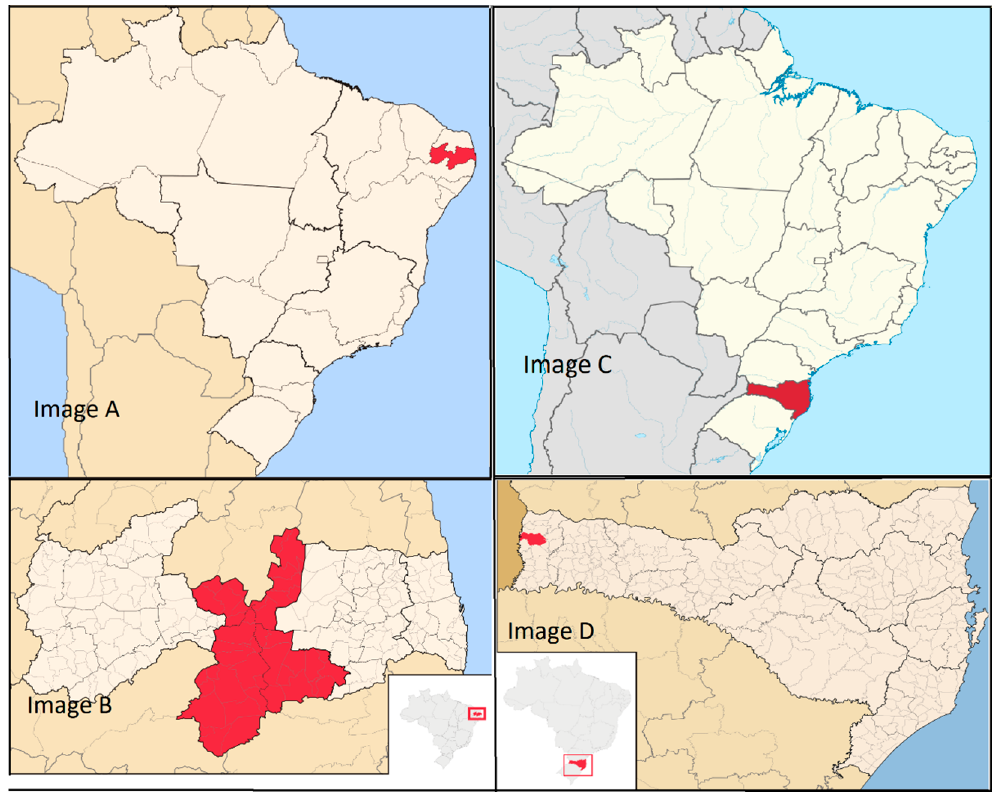
Figure 2. Case studies location. Case 1—Images A and B ; Case 2—Images C and D . Source: adapted from wikipedia.com. Accessed 05 August 2021.